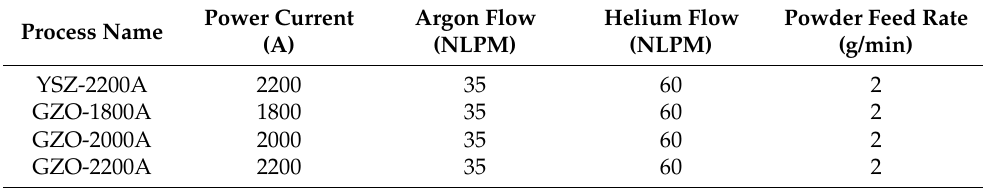
Table 1. Parameters used for the production of ceramic layers of YSZ and gadolinium zirconate in the PS-PVD experimental